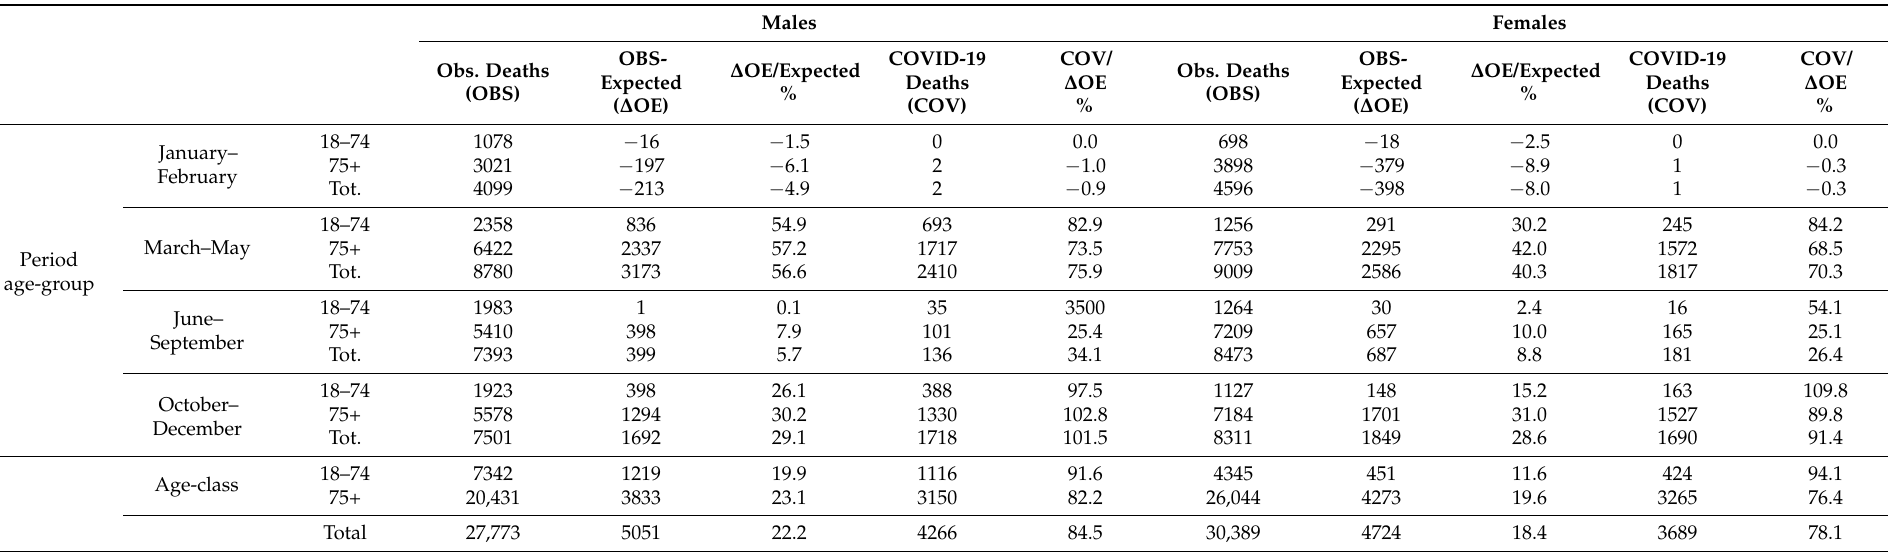
Table 1. Observed total deaths (2020), difference with expected deaths (2015–2019) and composition percent, observed COVID-19 deaths and ratio—on differences—percent, by sex, age group and period,